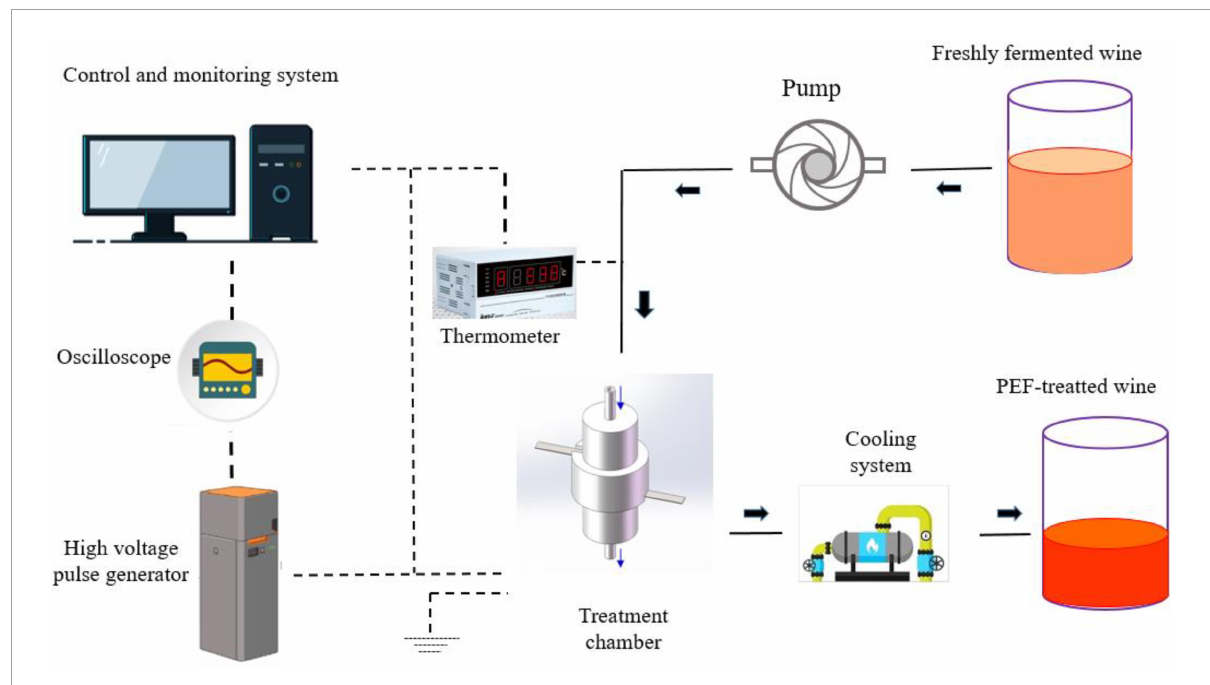
FIGURE4 Schematics diagram of a PEF treatment system for fermented wines. Adapted from Wang et al. (10).